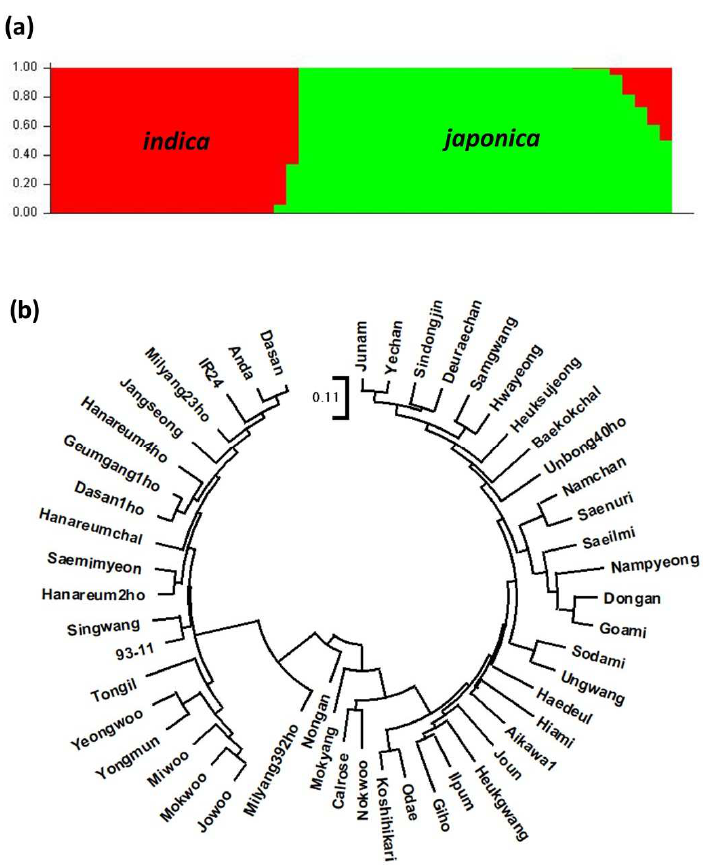
Figure 3. Population structure and phylogeny analysis of the 50 rice varieties used in this study. ( a ) Assignment of the rice varieties to two populations (japonica and indica) using the STRUCTURE 2.3.4 program. ( b ) Phylogenetic tree of the rice varieties. Their evolutionary history was inferred using the Neighbor-Joining method. The optimal tree with the sum of branch length = 5.76867357